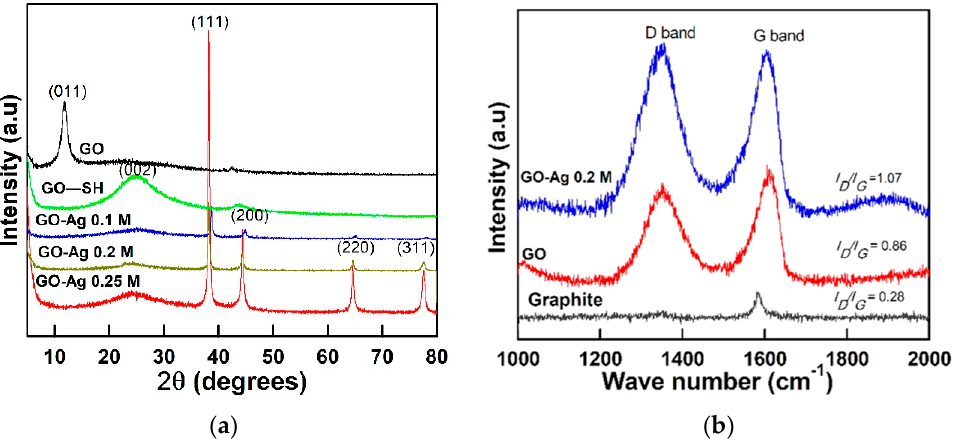
Figure 3. ( a ) The XRD graph of GO, GO–SH, GO-Ag 0.1 M, GO-Ag 0.2 M; and GO-Ag 0.25 M composites and ( b ) Raman analysis of graphite, GO, and GO-Ag 0.2 M composites.